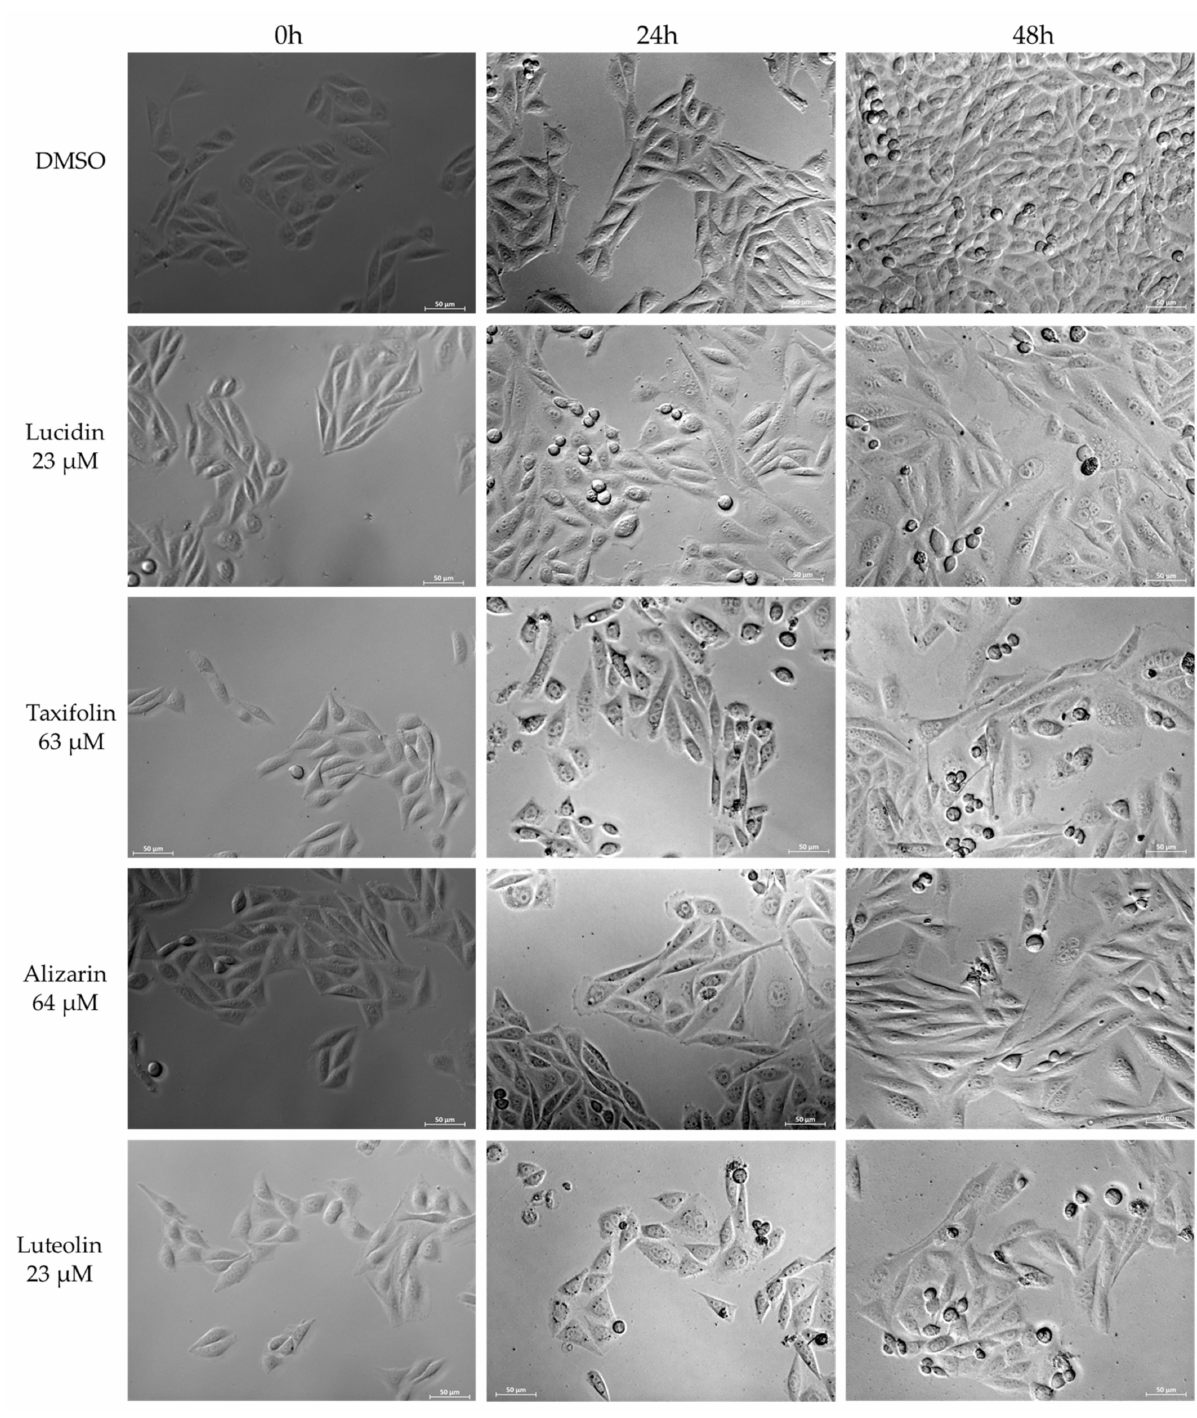
Figure 5. Phase contrast images showing HeLa cell morphology at 0, 24, and 48 h treatment at 20 × magnification. Scale-bar: 50 µ